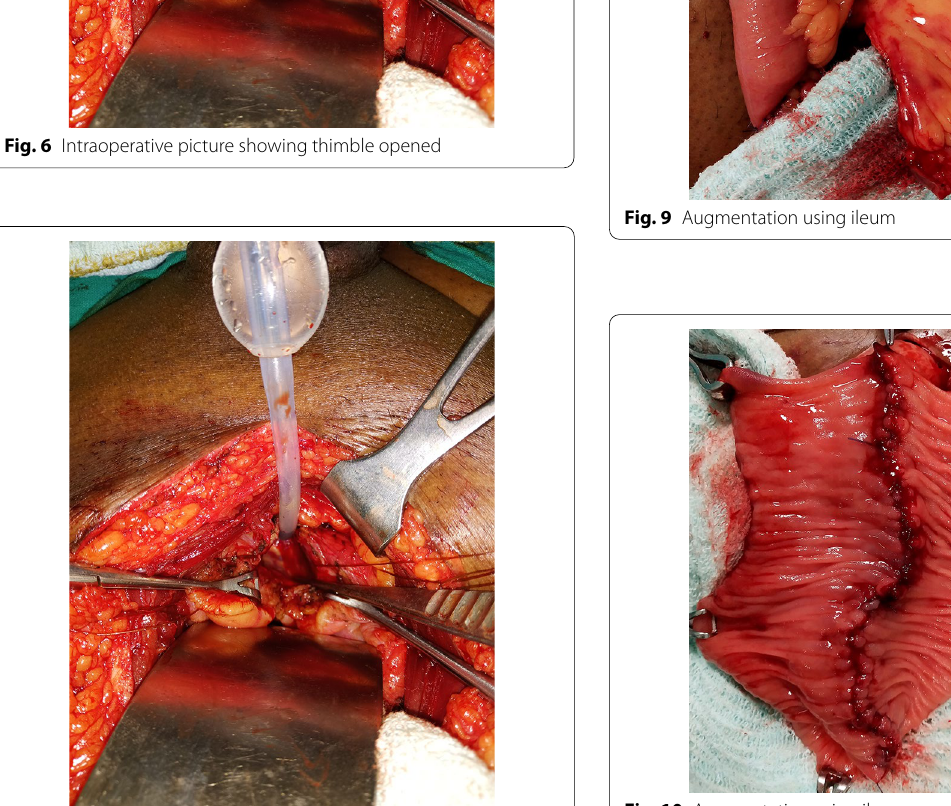
Fig. 10 Augmentation using